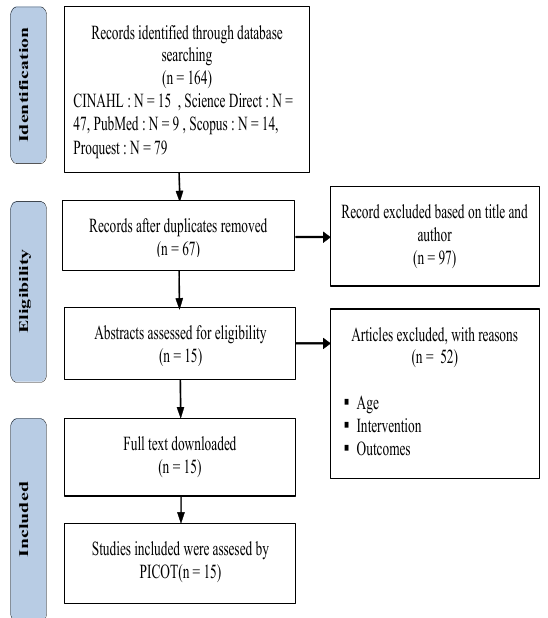
Figure 1. Prisma study flow